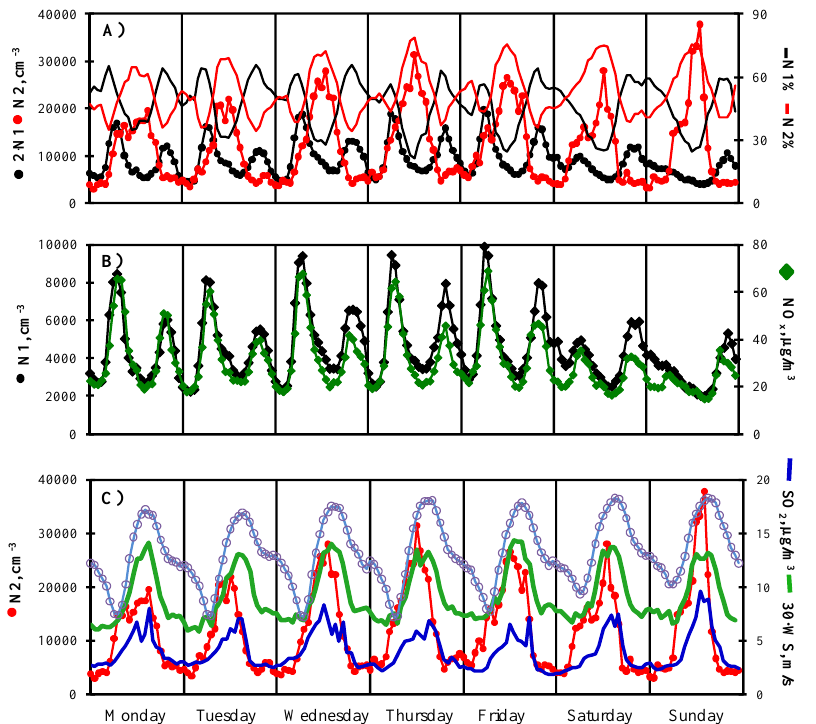
Fig. 6. Hourly average values of N1 and N2 particles (expressed in terms of absolute cm − 3 and relative contributions) and gaseous pollutant (NO x , SO 2 and O 3 ) concentrations and of wind speed for every day of the